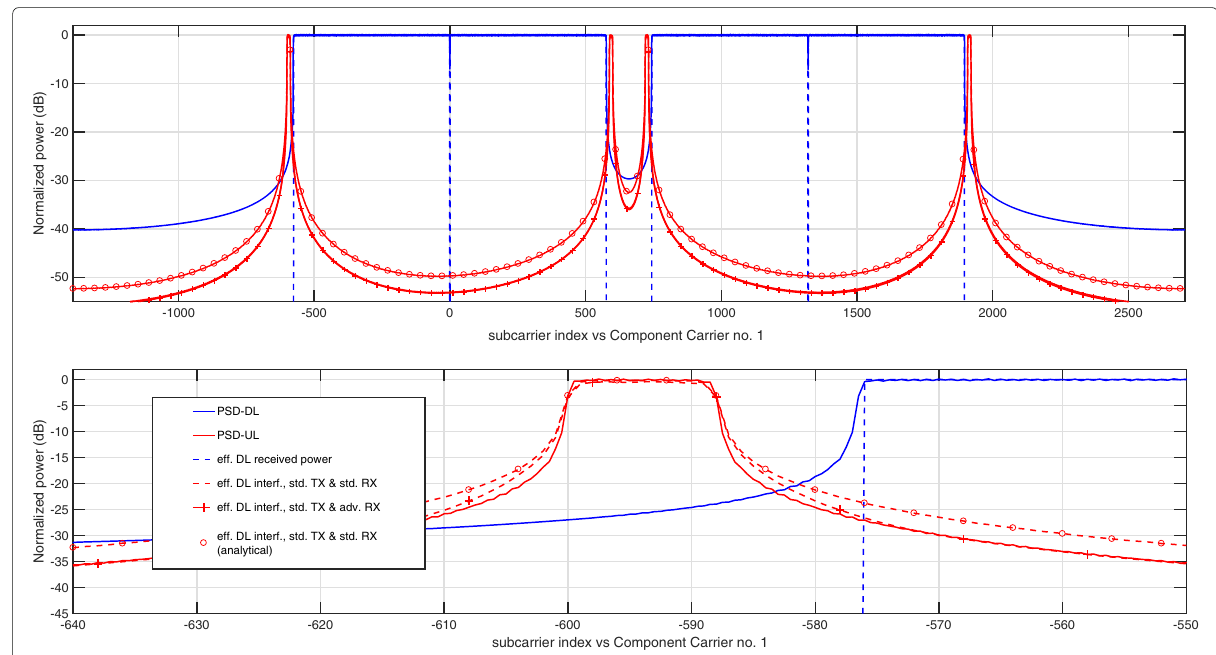
Fig. 8 Normalized PSDs of UL and DL transmitted signals, effective interference/useful signal power at user equipment—multichannel case. Only lower frequency edge is shown at the bottom figure